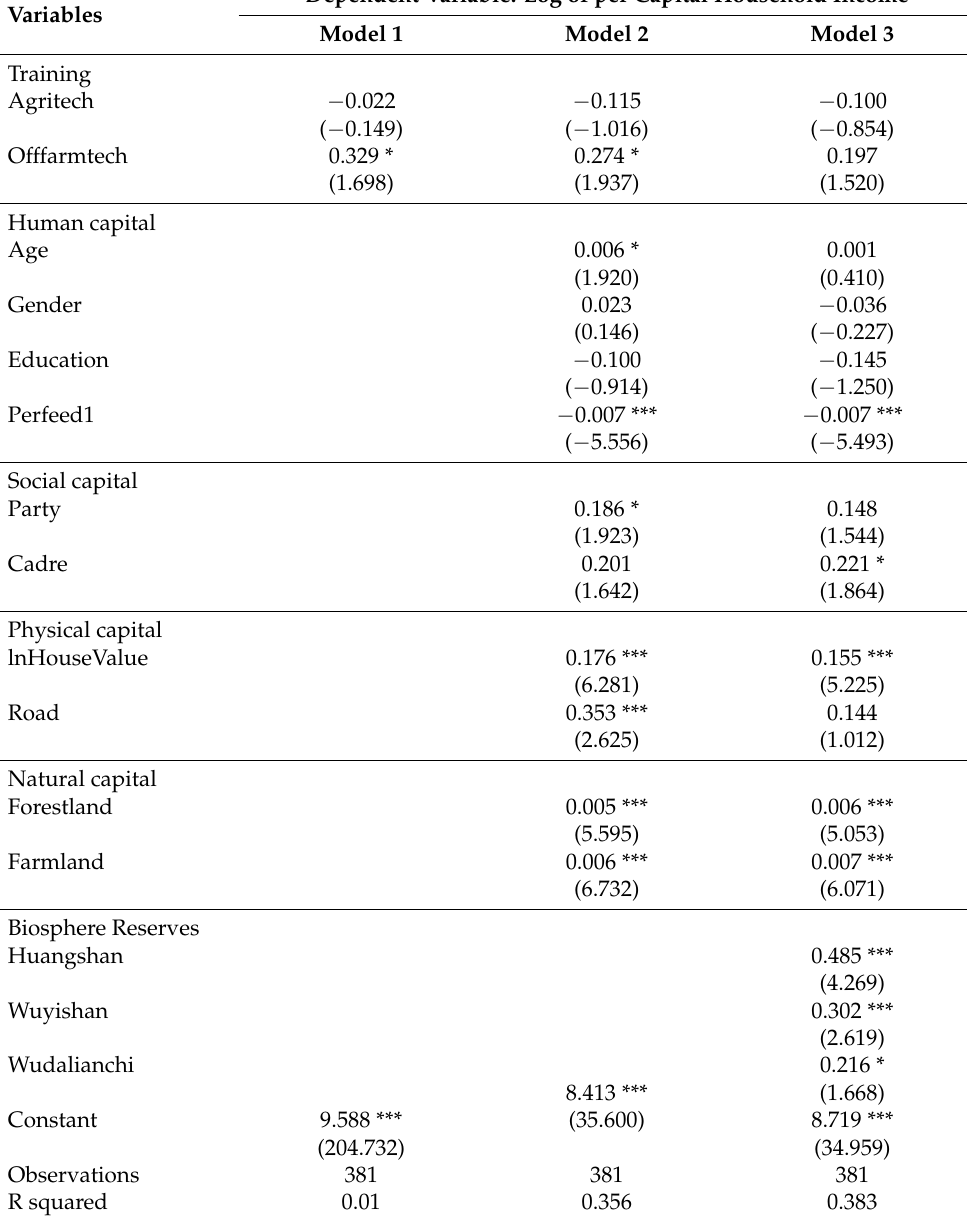
Table 3. The impact of skill training on total household